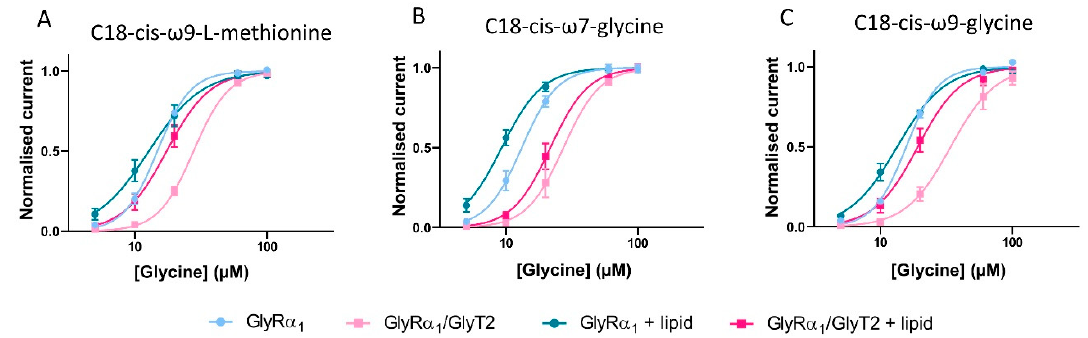
Figure 11. Pharmacological manipulation of fast-flow currents in GlyR α 1 and GlyR α 1 /GlyT co-expressed cells by bioactive lipids. ( A ) C18- cis - ω 9-L-methionine, ( B ) C18- cis - ω 7-glycine and ( C ) C18- cis - ω 9-glycine modulate the EC 50 s for glycine in cells expressing GlyR α 1 alone and co-expressed with GlyT2. Currents were normalised to I max and fit to the Hill equation. Symbols are mean ± SEM ( n = 5). Table 7. E ff ects of bioactive lipids on fast-flow EC 50 and Hill co-e ffi cient of GlyR α 1 and GlyR α 1 / GlyT2 expressing